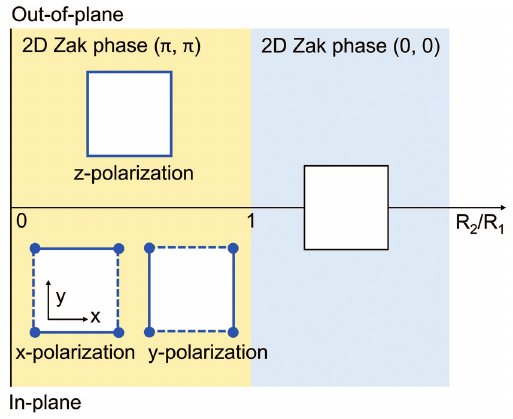
Figure 5: Diagram of topological phases and edge/corner modes. x -Axis represents the ratio between intercellular and intracellular distance ( R / R ). y -Axis distinguishes polarization of eigenmodes. 2 1 Boxes and their boundaries correspond to arrays consisting of N × N unit cells and their edge modes under open boundary condition. Solid black line: no edge state; dashed blue line: edge state overlapped with bulk states; solid blue line: edge state in a band gap. Blue dots at the corner represent the existence of corner modes in a band